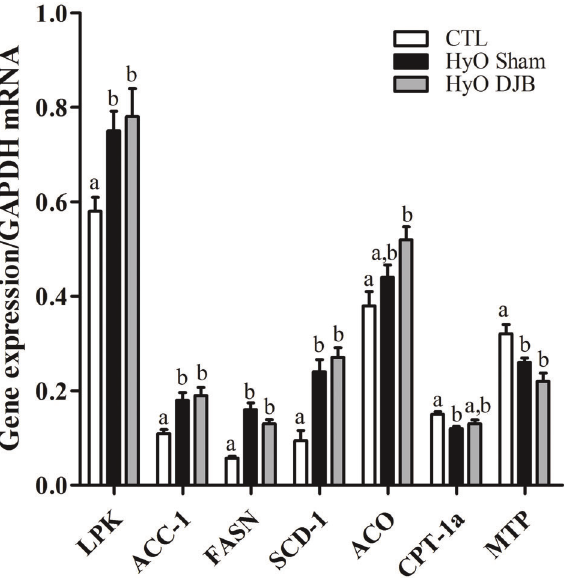
Figure 2. LPK , ACC-1 , FASN , SCD-1 , ACO , CPT-1a and MTP mRNA content in the livers of control (CTL), hypothalamic obese (HyO) Sham and HyO with duodenal-jejunal bypass (DJB) rats. Data are reported as means ± SEM (n=5 – 8). P o 0.05, different letters indicate signi fi cant differences (one-way ANOVA followed by the Tukey